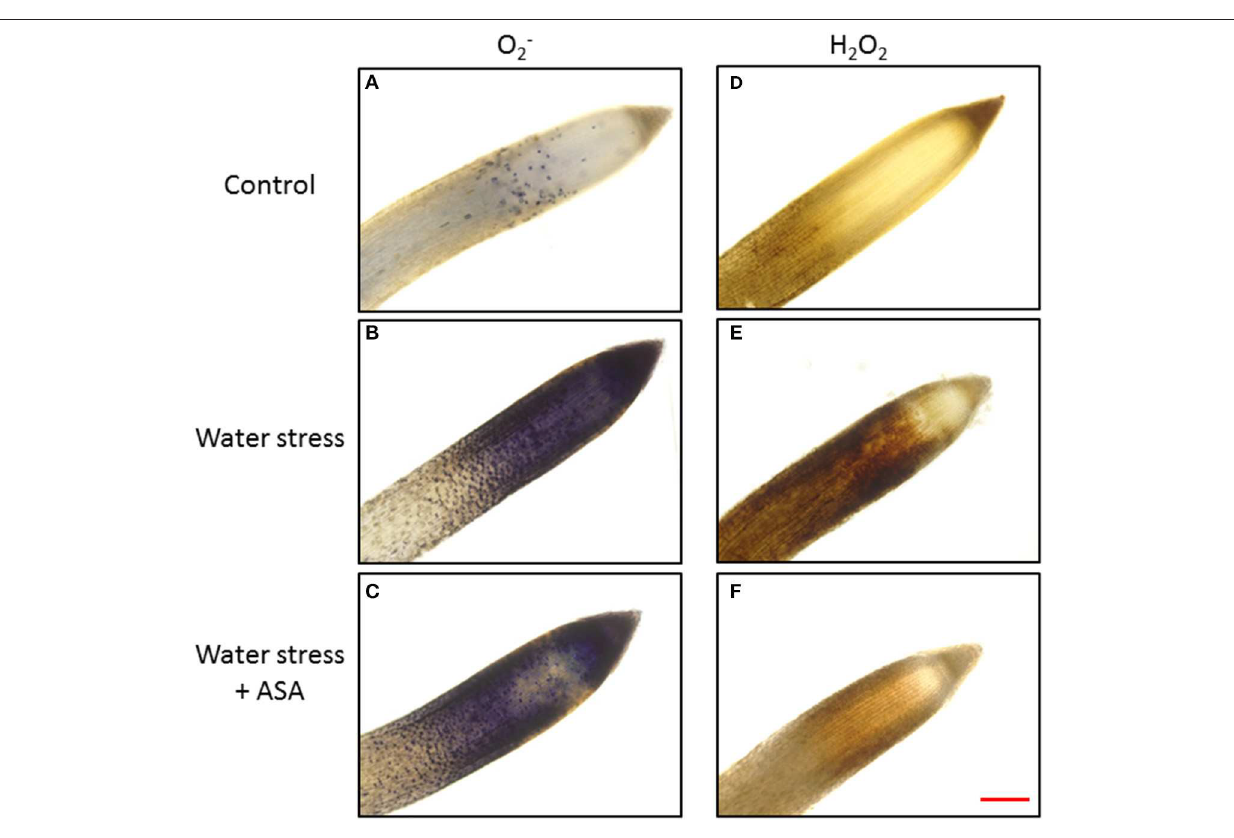
FIGURE 4 | Histochemical staining of tall fescue roots for visual localization of super oxide (O − 2 ) (A for non-stress control, B for water stress, and C for water stress with ASA treatment) and hydrogen peroxide (H 2 O 2 ) (D for non-stress control, E for water stress, and F for water stress with ASA treatment). Bar represents for 100 µ